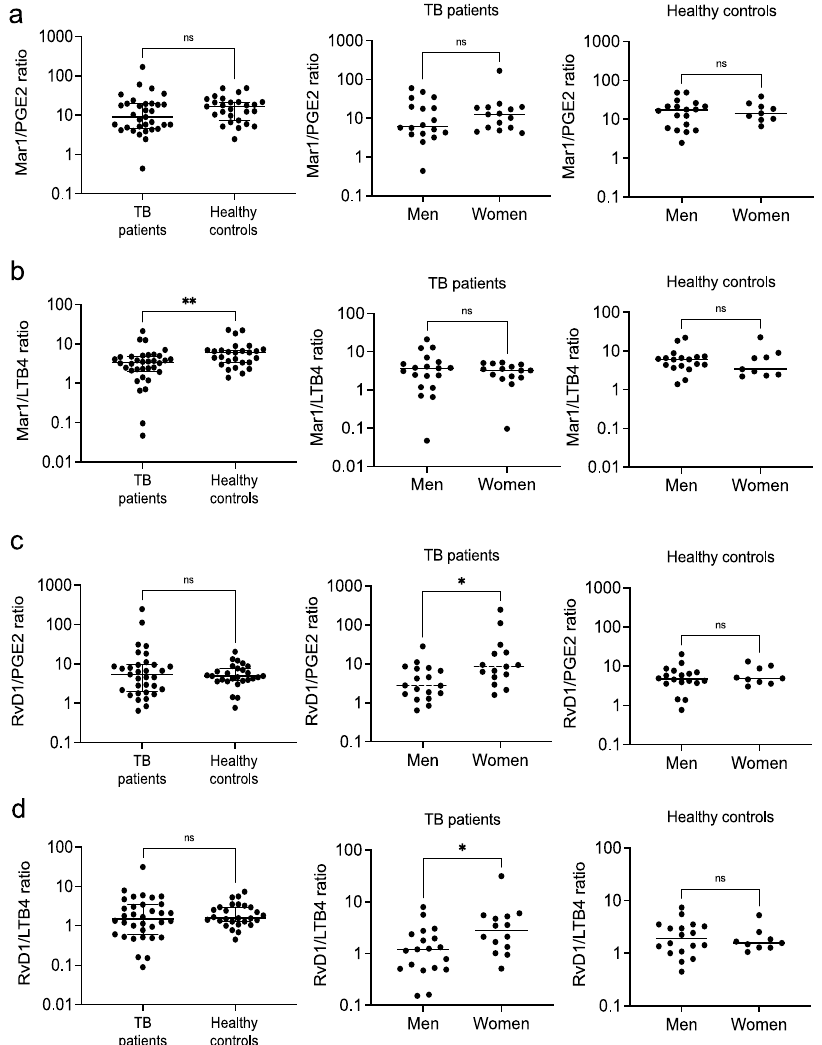
Figure 4. Pro-resolutory/pro-inflammatory ratios of circulating eicosanoids. Mar1/PGE2 ( a ), Mar1/LTB4 ( b ), RvD1/PGE2 ( c ), and RvD1/LTB4 ( d ) ratios were calculated from the serum levels of eicosanoids of patients with pulmonary tuberculosis and healthy controls. Individual results with medians and interquartile ranges are depicted ( left ). Data were disaggregated by sex for both the patients ( center ) and controls ( right ); individual results with medians are depicted. * p < 0.05, ** p < 0.01, ns = not significant.